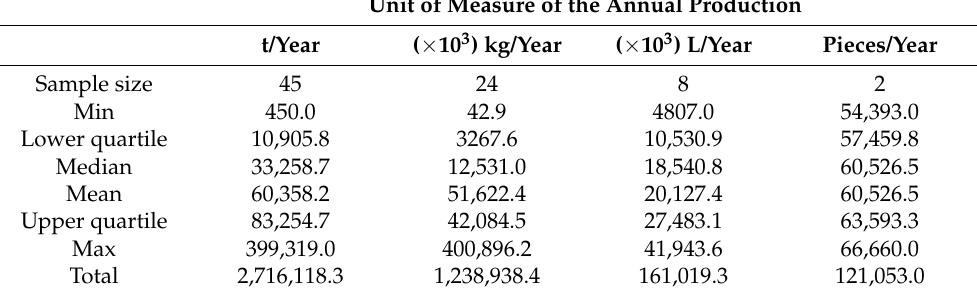
Table 1. Statistical distribution functions of the annual production of dairy enterprises investigated, varying the unit of measure. Unit of Measure of the Annual Production t/Year ( × 10 3 ) kg/Year ( × 10 3 )